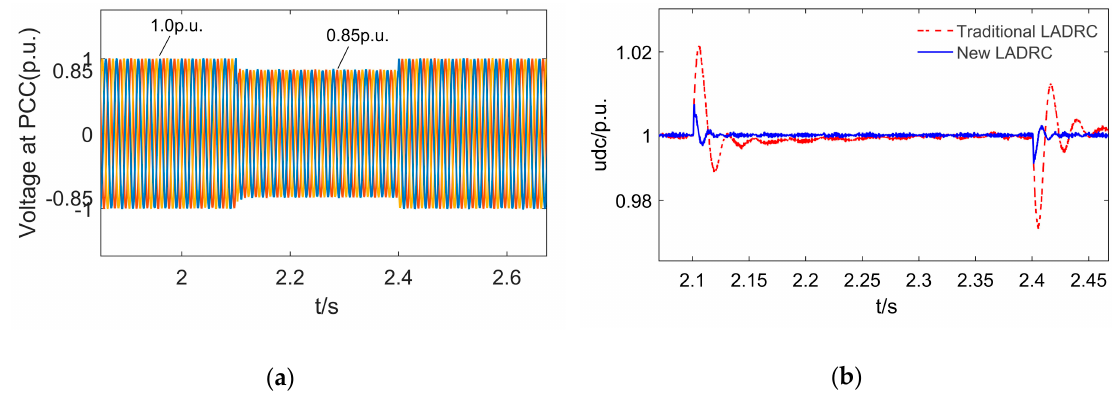
Figure 16. Dynamic response of a 1.5 MW permanent magnet synchronous generator (PMSG) with the traditional LADRC and new LADRC during the grid side voltage drops to 85%: ( a ) voltage at PCC; ( b ) capacitor voltage u dc .